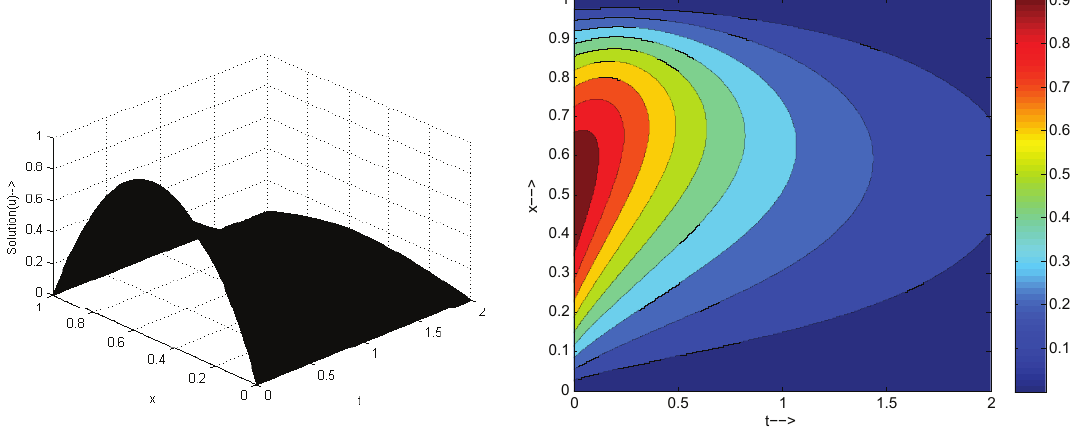
Fig. 6: Physical behavior of numerical solutions of Example 2 at different times in 3D and contour for Δx = 0.0125 , ν = 0.1 at different times with Δt = 0.001 .